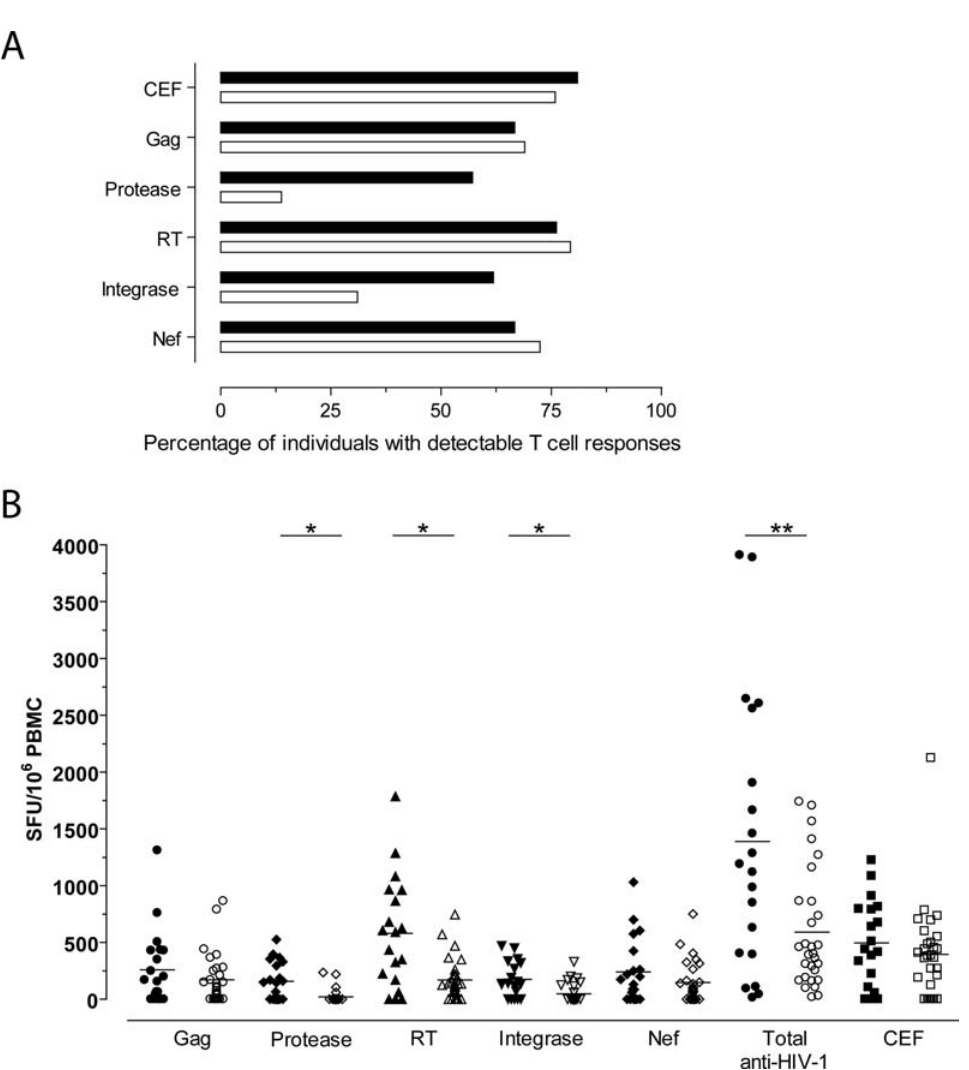
Figure 1. Responses to HIV-1 peptides and the CEF pool. A) Percentage of individuals making responses from either group: solid bars indicate the viremic partner group and open bars represent the non-viremic partner group. There was a significant difference in the number of individuals responding to Protease and Integrase peptide pools (p=0.04 and p=0.002 respectively), as determined by Fishers exact test. No difference was seen for any other stimuli. B) Magnitude of IFN- c T cell responses to the HIV-1 or CEF peptide pools, and the total cumulative anti-HIV-1 response. Responses from individuals within the viremic partner group (closed symbols) and individuals within the non-viremic partner group (open symbols) showed significant differences for Protease, RT, Integrase and the total cumulative anti-HIV-1 response, *p , 0.001 and **p=0.0274 respectively. The median of each group is plotted as a horizontal line. doi:10.1371/journal.ppat.1000185.g001 PLoS Pathogens |